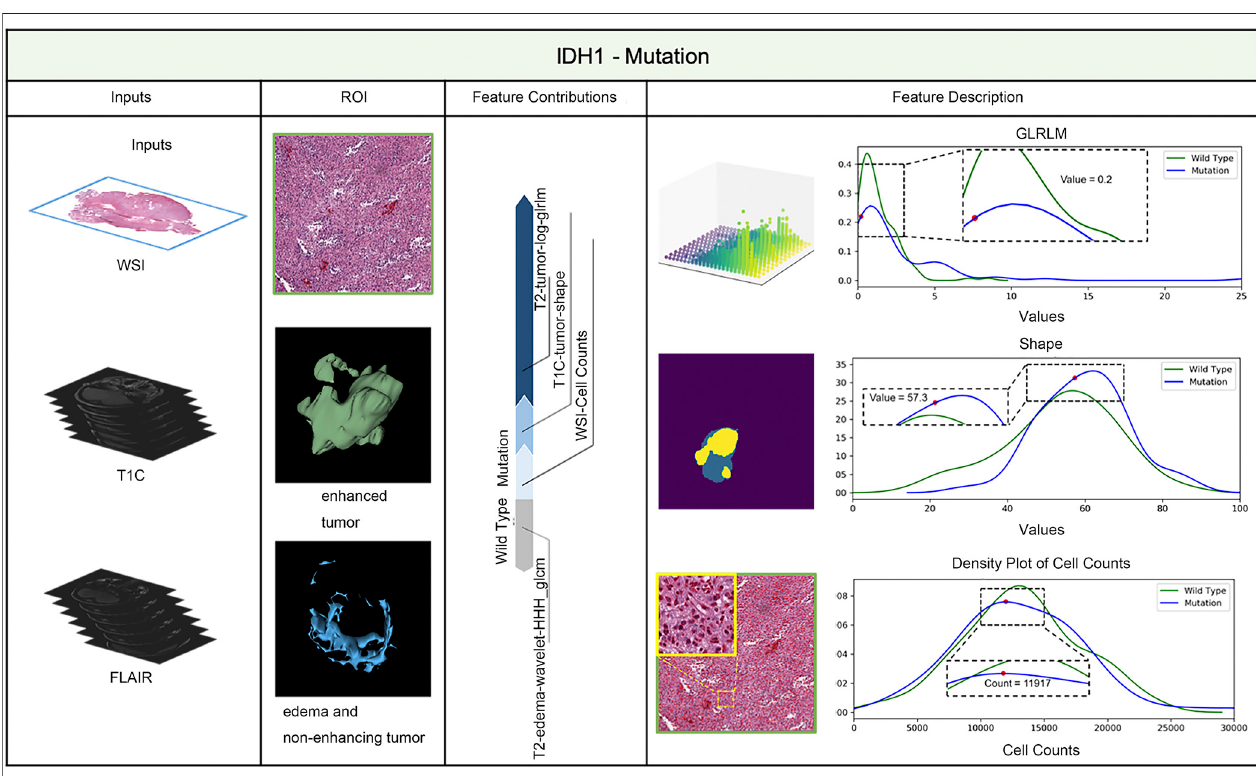
FIGURE 3 | IDH status prediction result explanation of a representative case with the LIME algorithm for the RF model (IDH-Wild type case).